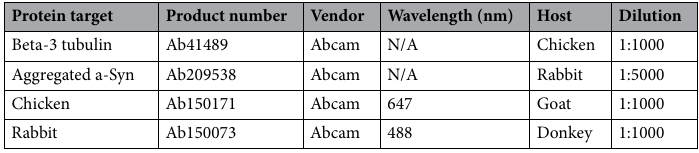
Table 1. Immunostaining